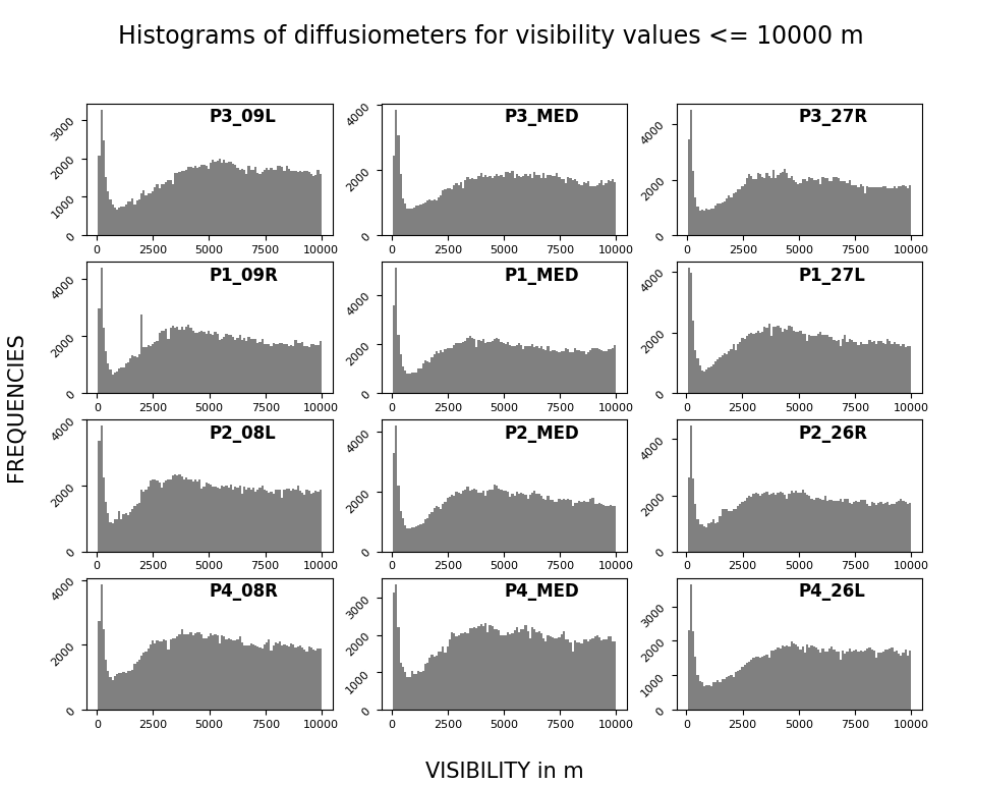
Figure 3. Panel of histograms of the visibility under 10,000 m for each forward-scattering sensors. See Figure 1 and Table 1 for the name and location of visibility sensors.